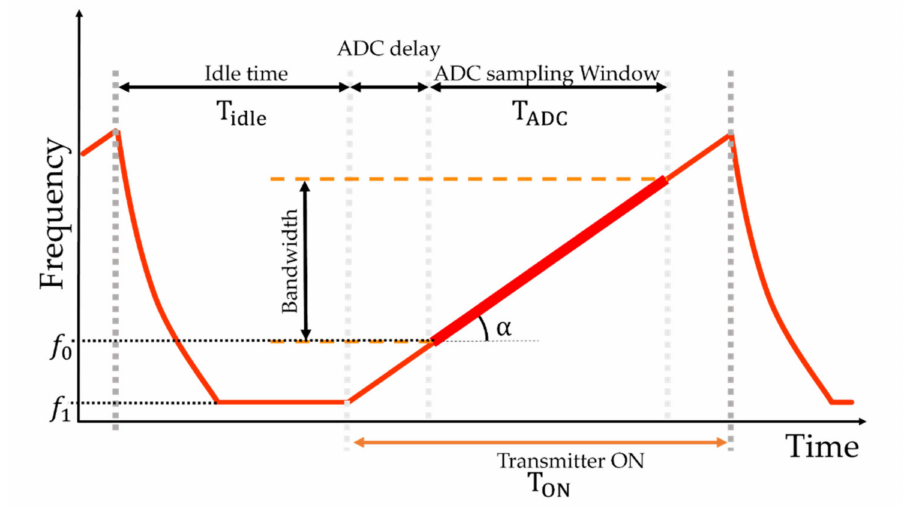
Figure 4. Chirp geometry of